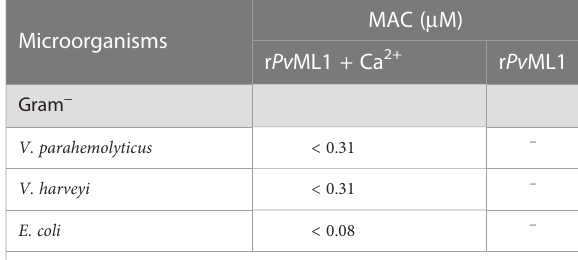
TABLE 2 Agglutinating activity of Pv ML1.